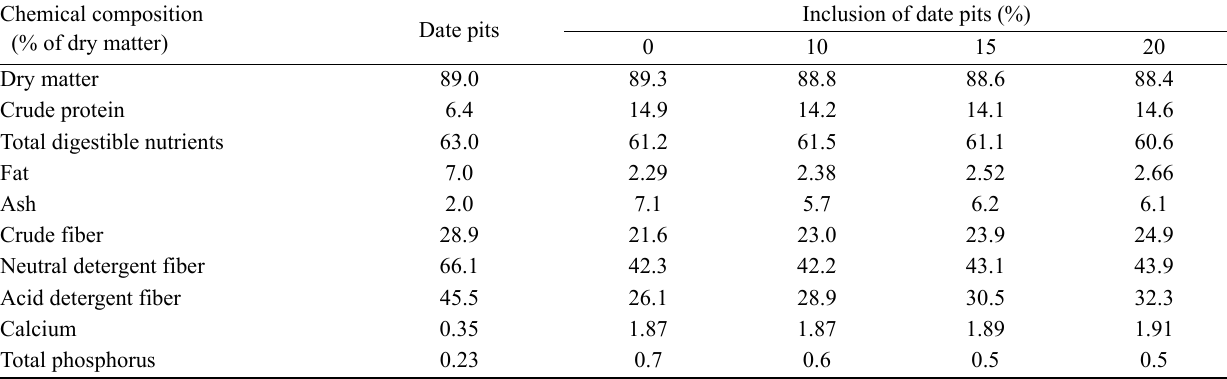
Table 2. Chemical composition of date pits and experimental diets Chemical composition (% of dry